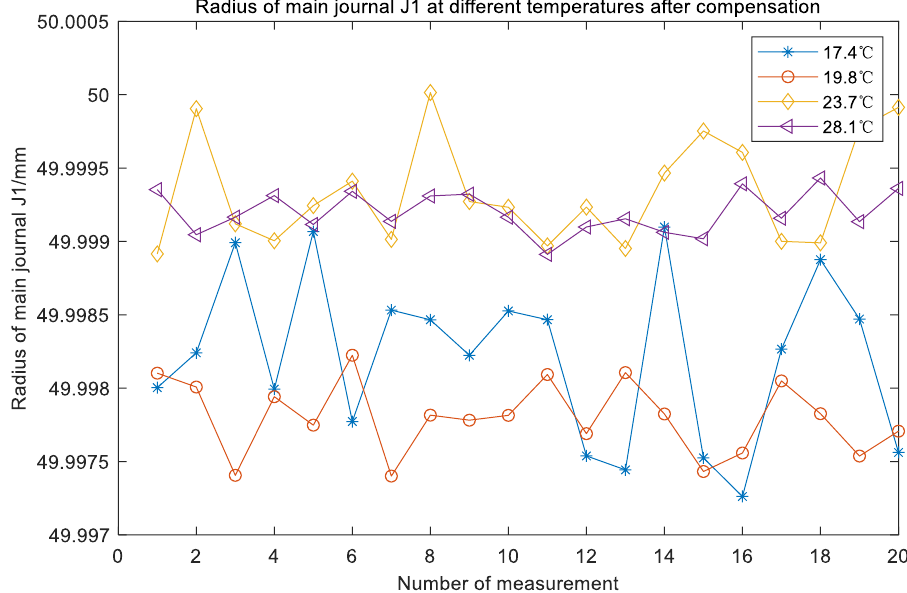
Figure 13. Measured radius after temperature compensation.